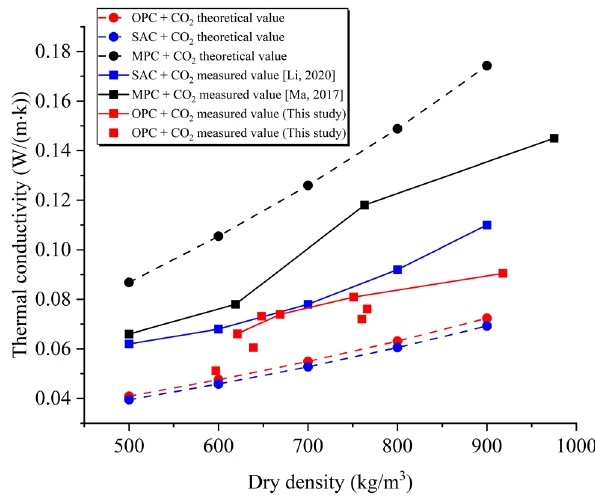
Figure 6. Distribution law of the thermal conductivity of CFC [17,19].